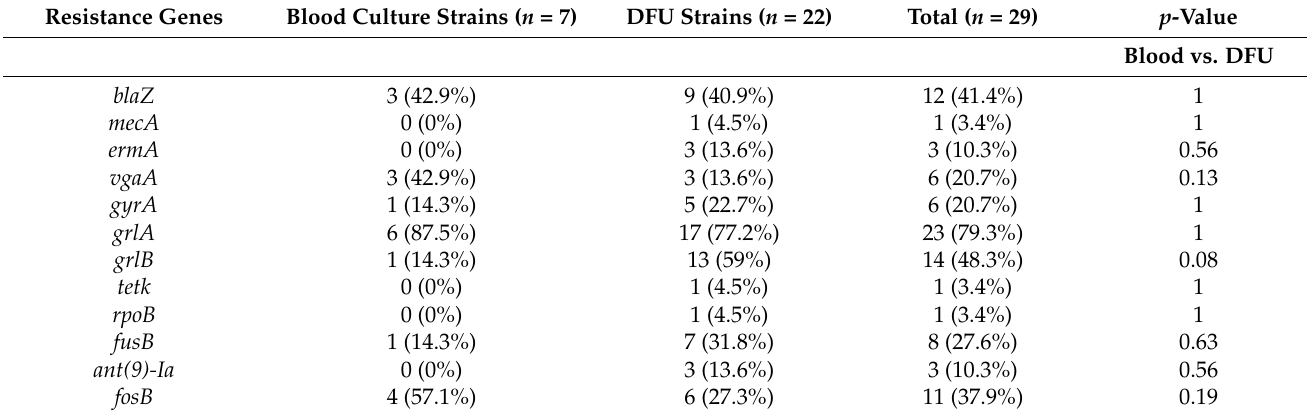
Table 2. Comparison of resistomes between blood culture and DFU S. pettenkoferi strains. Resistance